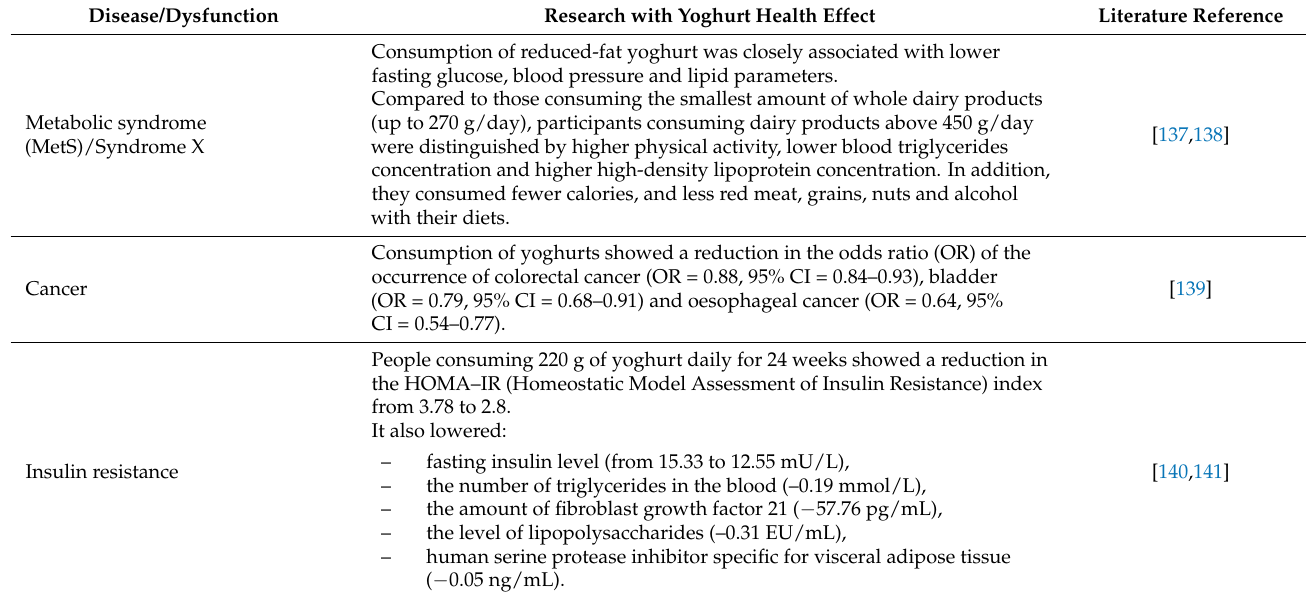
Table 6. Exemplary studies on the impact of eating yoghurt on the body in the case of the most common civilization